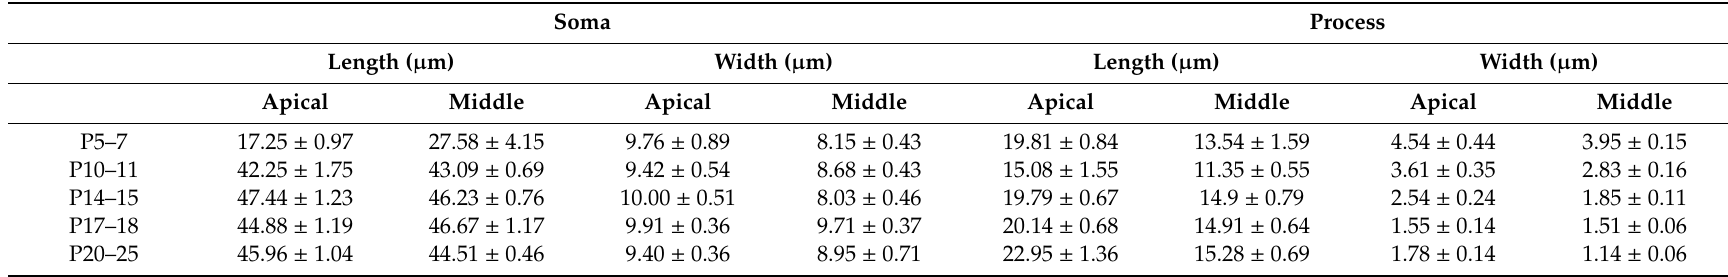
Table 1. Morphology of the developing Deiters’ cells. The length and width of the soma and the phalangeal process were measured in two turns of the cochlea (mean ±